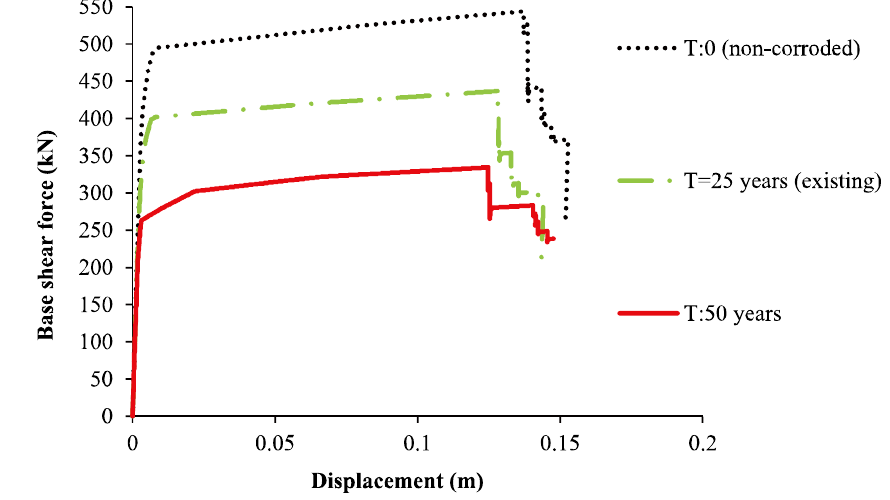
Figure 8. Time-dependent capacity curves for non-corroded and corroded